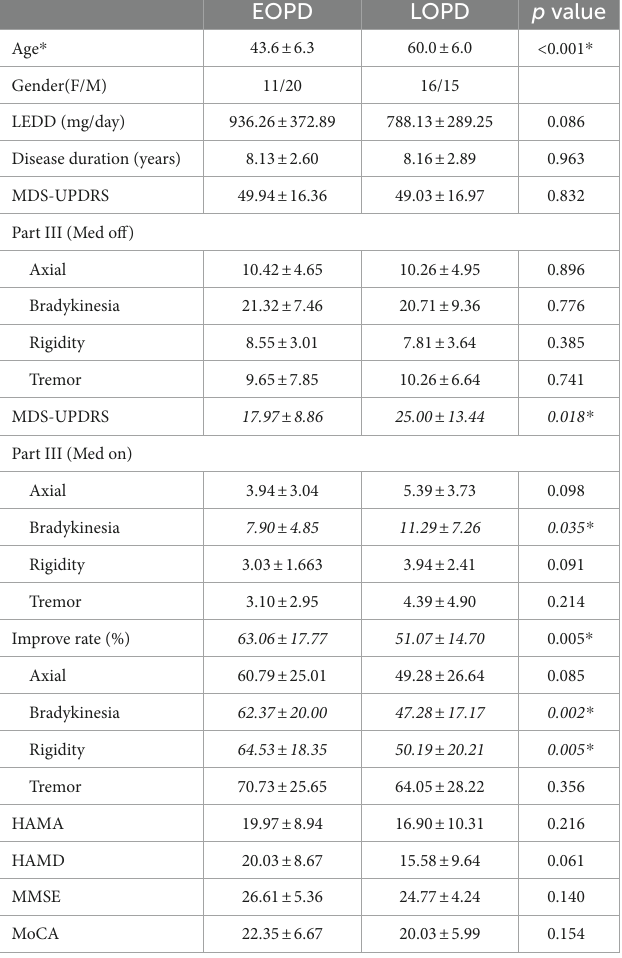
TABLE 1 Demographic and clinical characteristics.